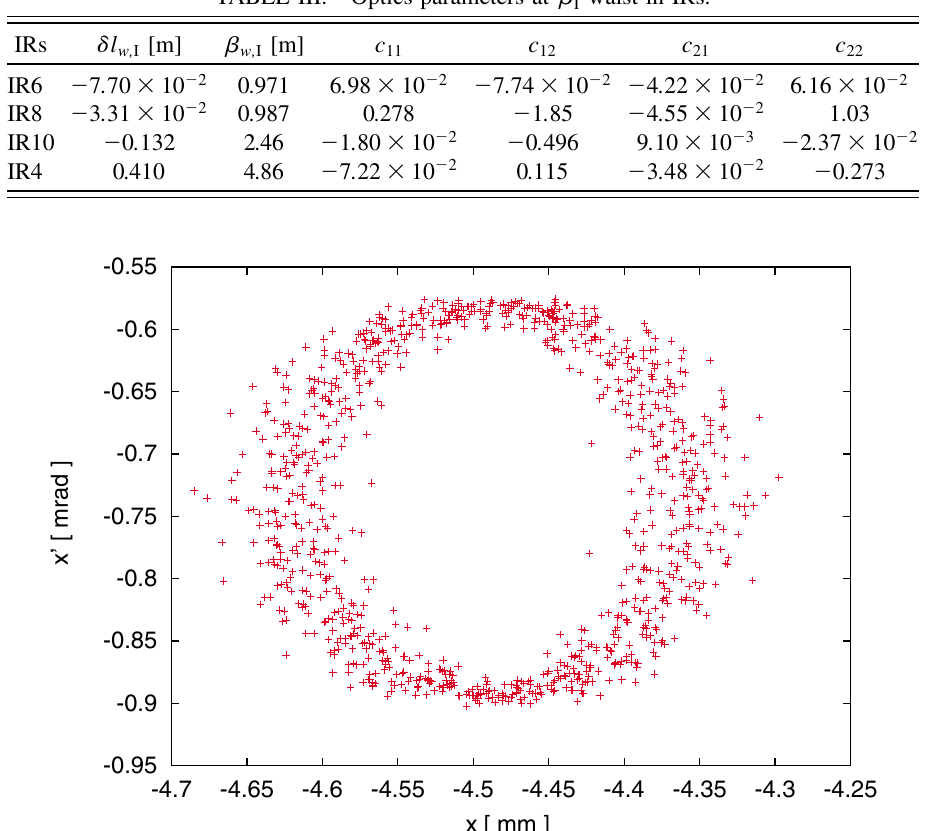
FIG. 2. (Color) Measured TBT ( x ; x 0 ) at IR6